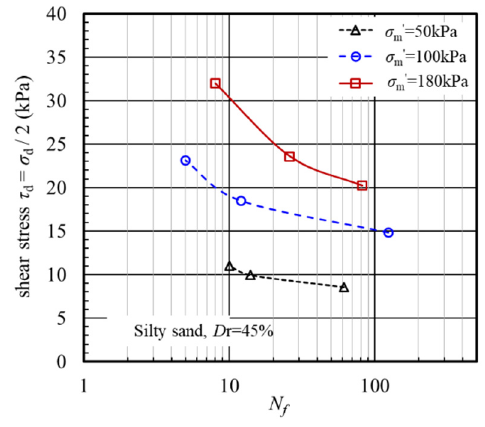
Figure 10. Cyclic strength curve of silty with different confining pressure.